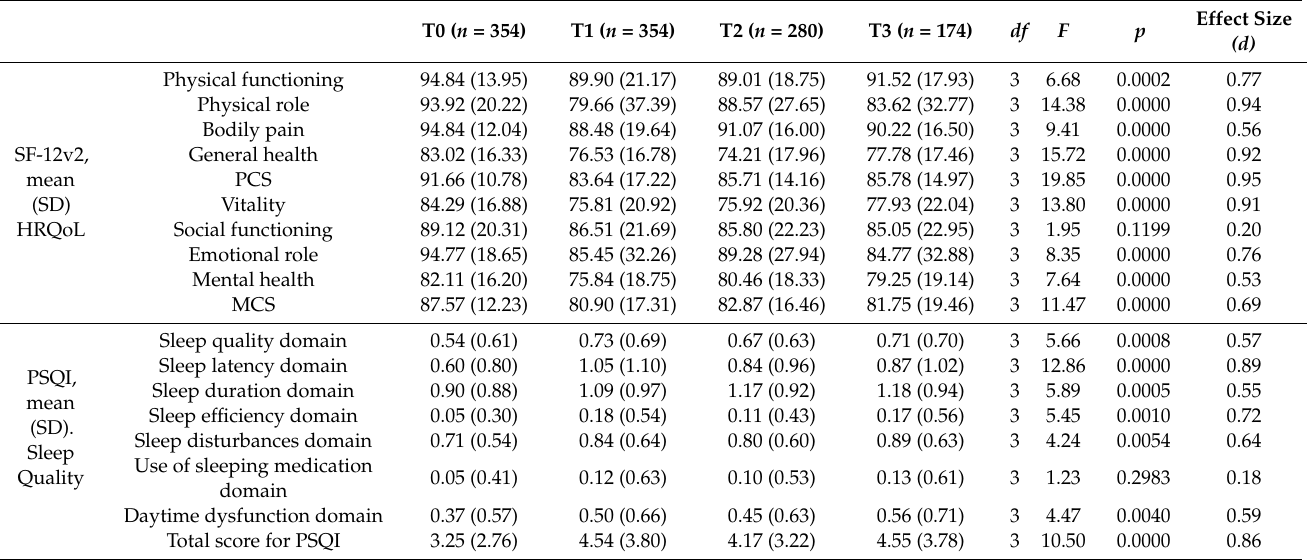
Table 2. ANOVA repeated measures. Differences between measurement times for quantitative variables: HRQoL and sleep